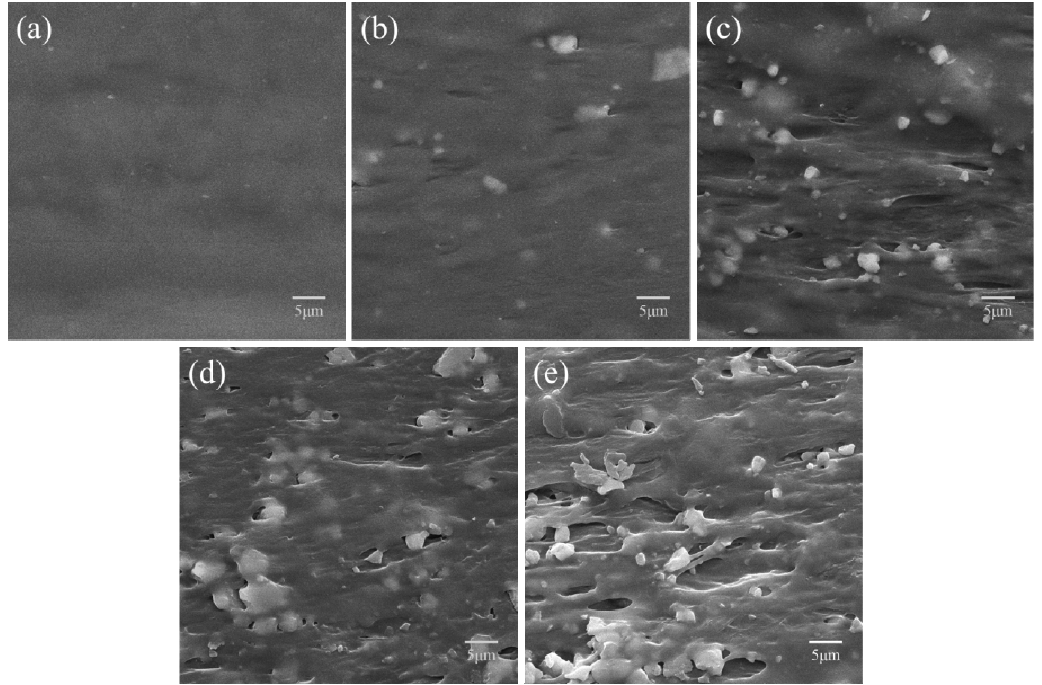
Figure 5. SEM cross section morphologies of ( a ) PHBV scaffold, ( b ) PHBV/5%CS scaffold, ( c ) PHBV/10%CS scaffold, ( d ) PHBV/15%CS scaffold, and ( e ) PHBV/20%CS scaffold.